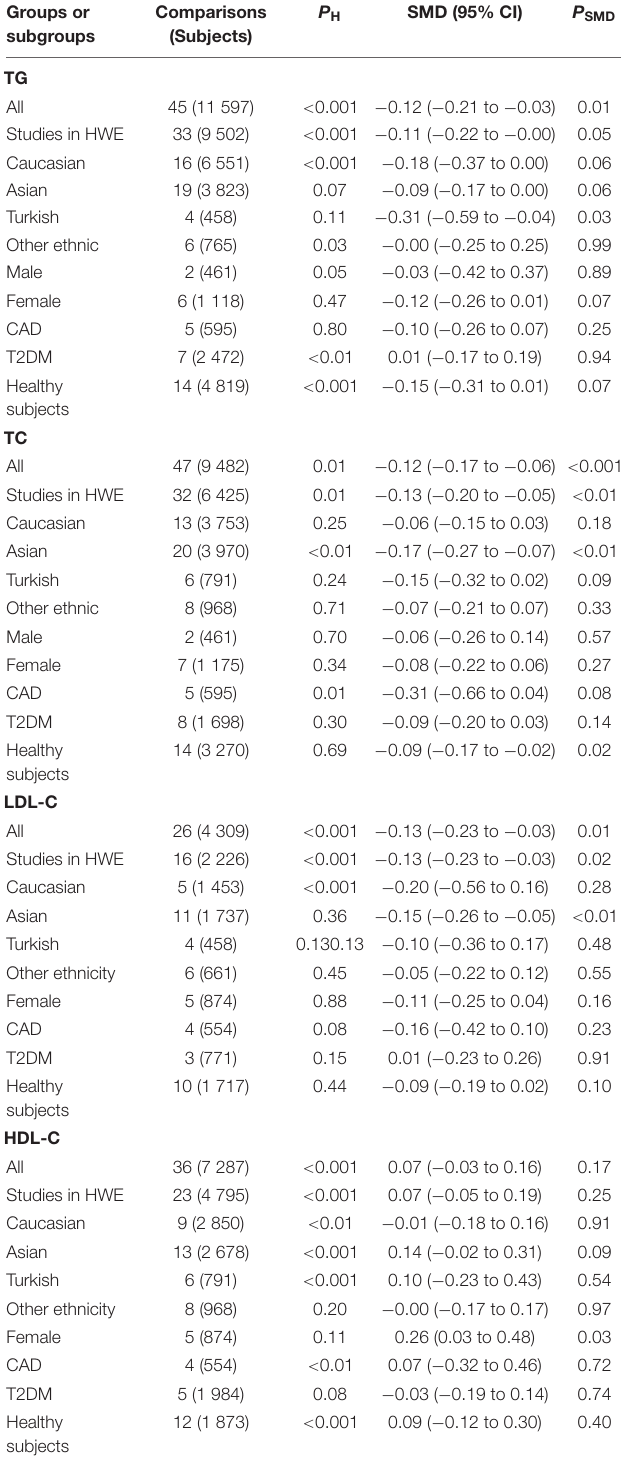
TABLE 1 | Meta-analysis of SERPINE1 rs1799889 polymorphism with lipid levels. Groups or